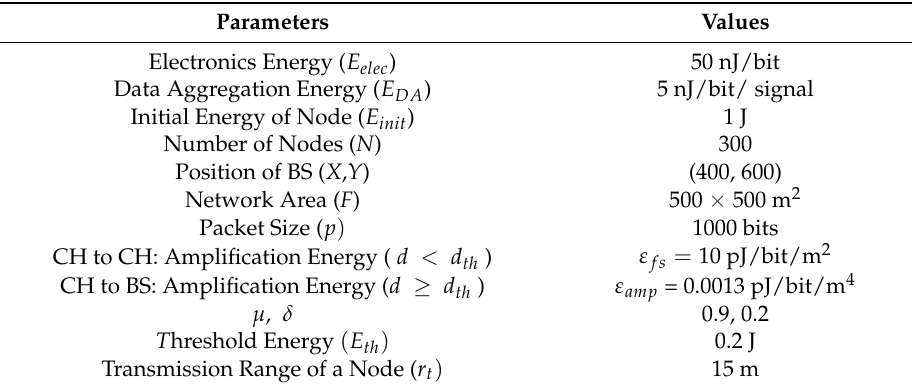
Table 2. Simulation